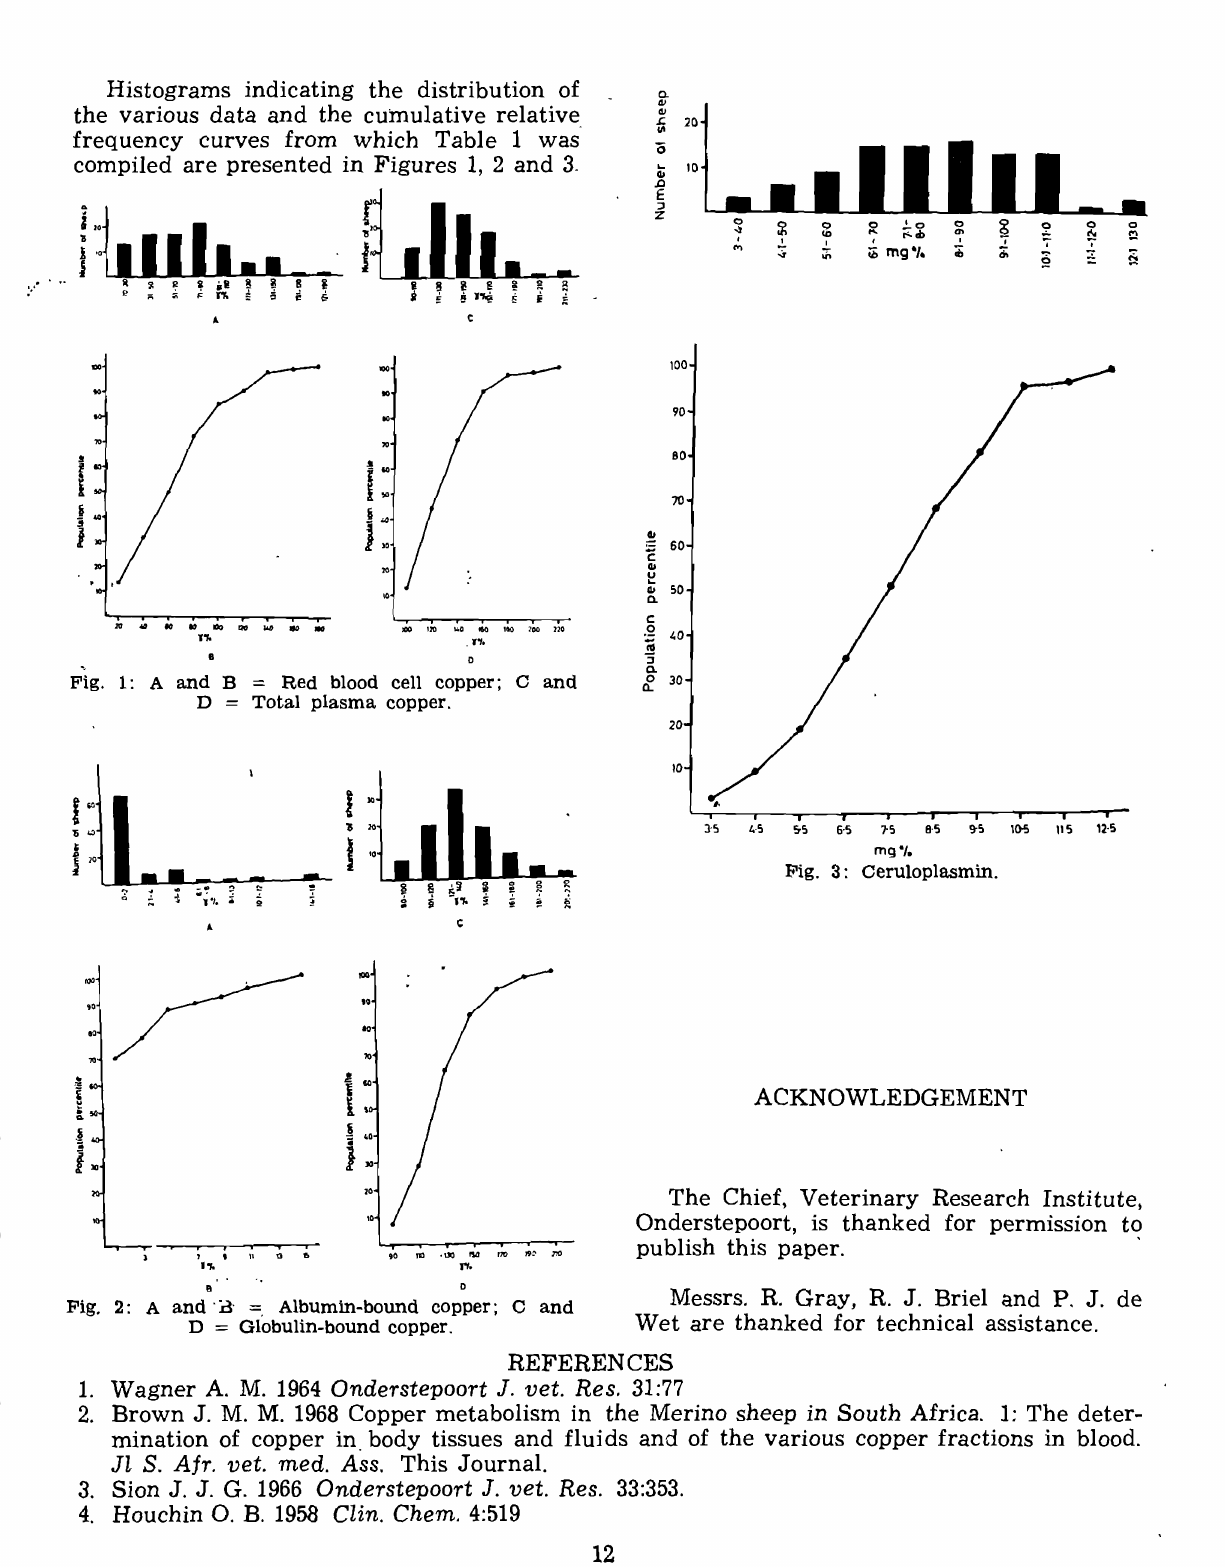
Fig. 2: A and':d' . AlbUmin-bound copper; C and D = Globulin-bound copper.